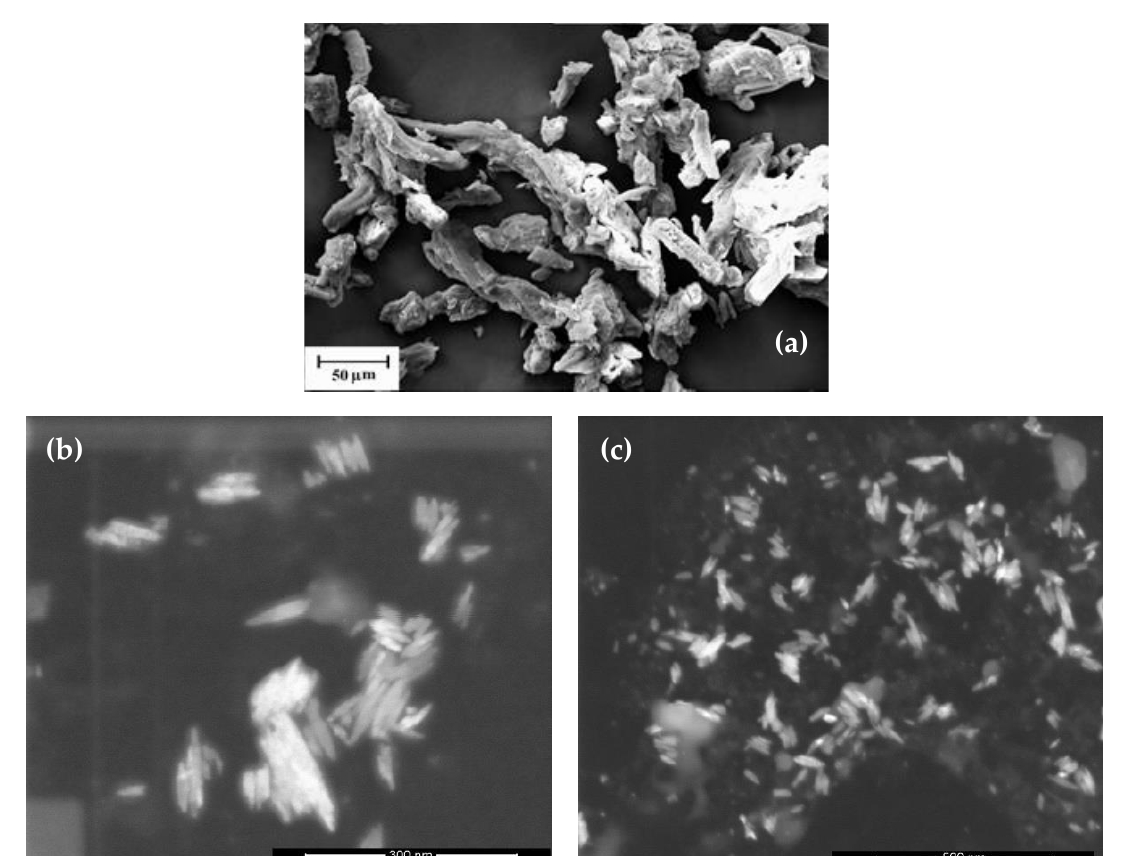
Figure 1. SEM images for ( a ) MCC and ( b and c ) CNC extracted from MCC by acid hydrolysis.